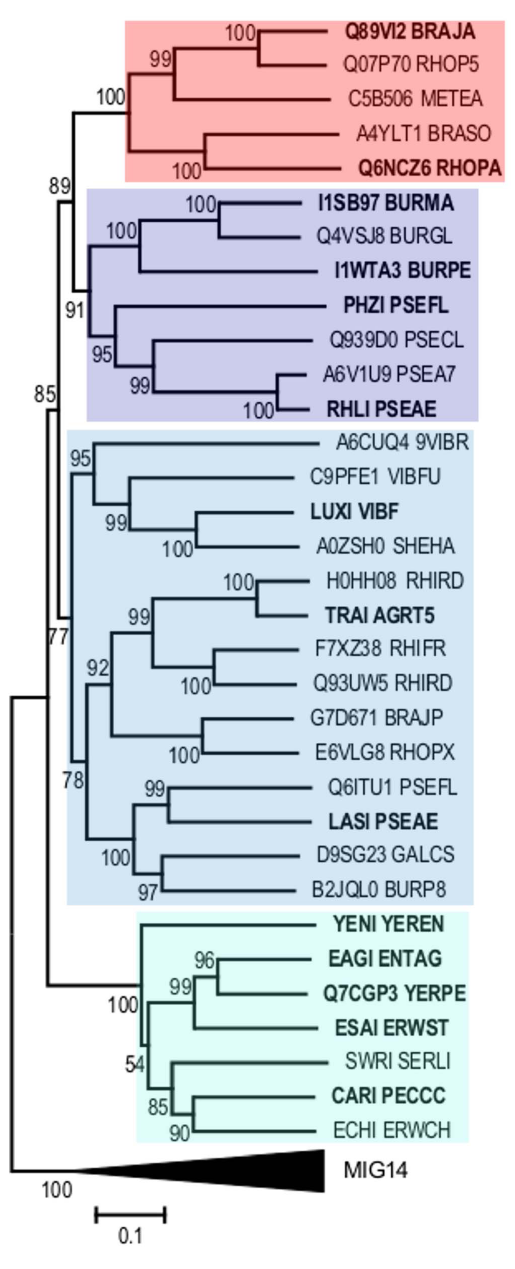
Figure 2. Protein phylogeny of acyl-HSL synthases from Pfam PF00765. The sequences used in the analysis are labeled with the uniprot identifier followed by the organism identifier. BmaI1 is I1SB97_BURMA and BjaI is Q89V12_BRAJA. The clade containing CoA- utilizing acyl-HSL synthases is highlighted in red and the clades containing acyl-ACP-utilizing acyl-homoserine lactone synthases are highlighted in shades of blue. The Mig14 family (PF07395), also from the acetyltransferase-like clan (CL0257), was used as an outgroup and is collapsed as a black triangle. Labels in bold have been experimentally shown to use ACP or CoA substrates. The percentage that each branch was observed during bootstrap resampling is shown next to the branch.